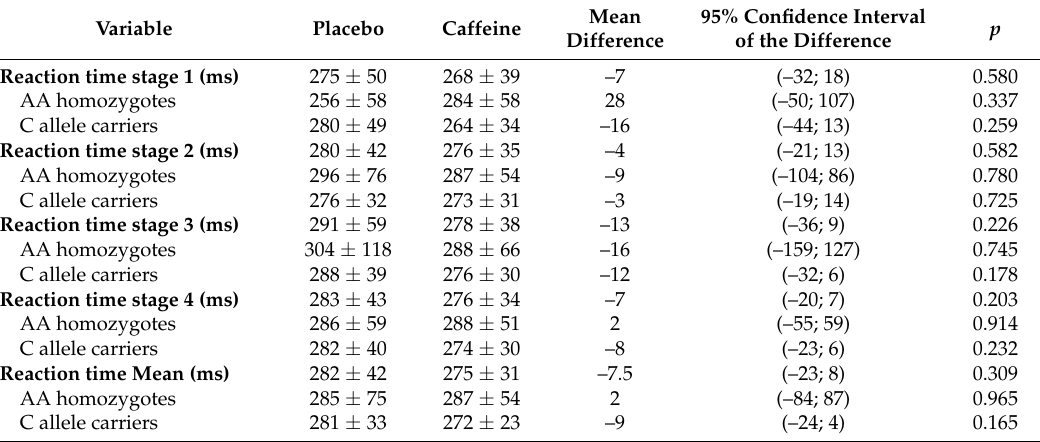
Table 1. Reaction times in the visual attention test with the ingestion of 3 mg · kg − 1 of caffeine or a placebo for AA homozygotes and C-allele carriers.